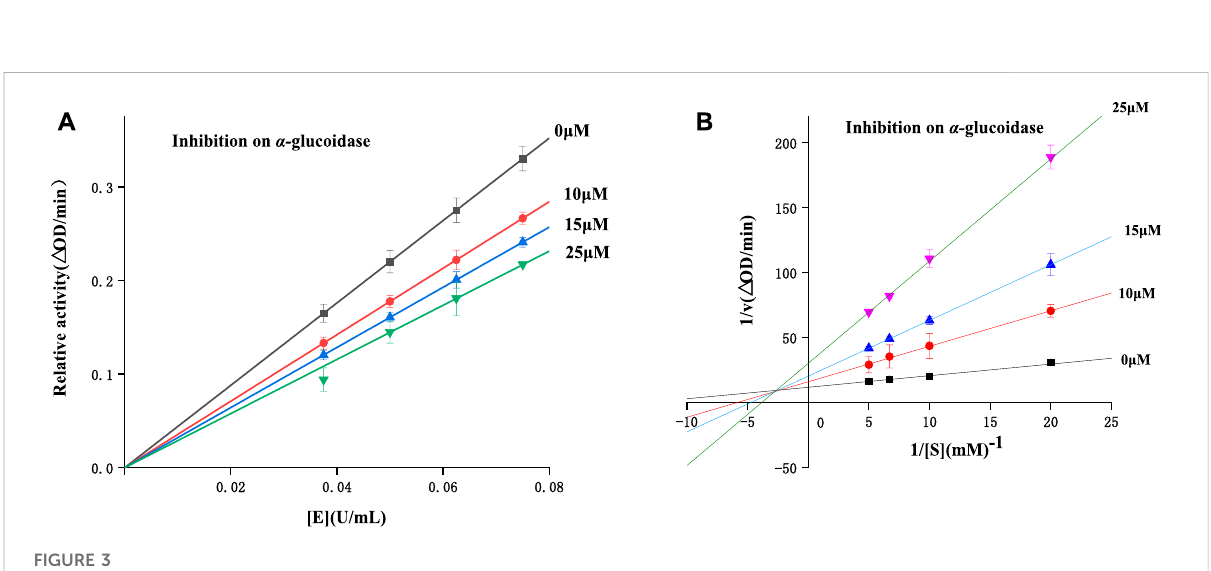
FIGURE 3 Inhibitory mechanism (A) and type assay (B)